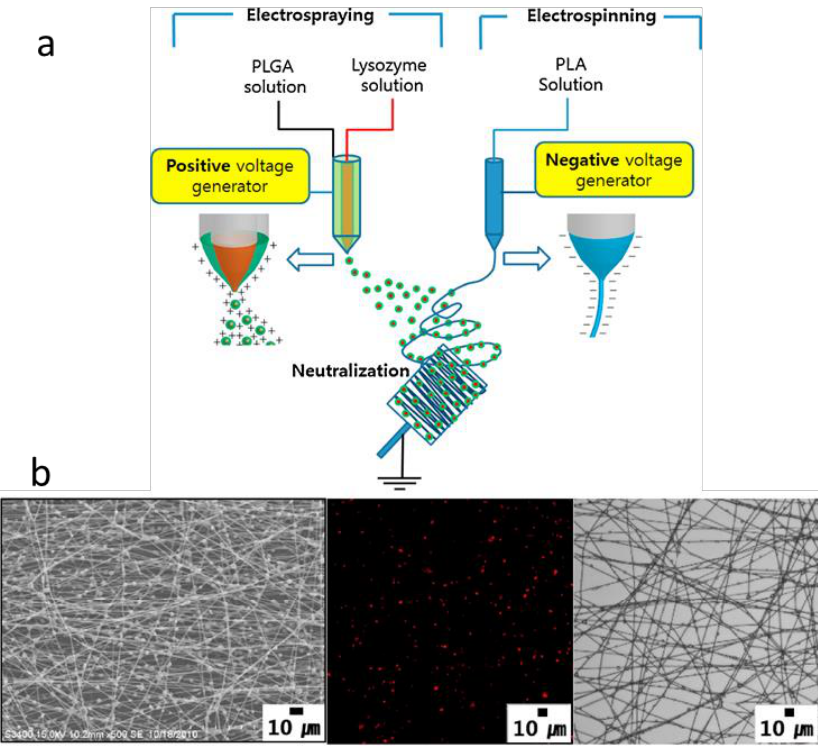
Figure 15. ( a ) In situ combination of encapsulated particles and fibers via electrospinning and electrospray techniques. ( b ) SEM ( left ) and confocal microscopy ( middle and right ) images of particle-fiber composites produced with different solvent compositions: EA:BA = 1:9, Reproduced with permission from [110] (License number: 5232980582910).